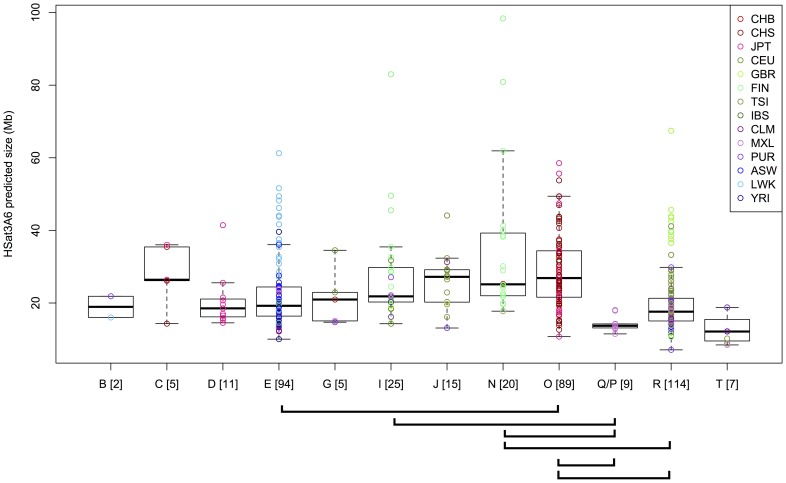
HSat3A6 (DYZ1) array size estimates in 396 individuals.Each circle represents an HSat3A6 size estimate for a single individual, and it is colored by the population designation of that individual. Individuals are grouped by Y haplogroup assignments, and boxplots illustrate the distribution of array sizes within each haplogroup. Brackets below the plot indicate pairs of haplogroups with p<0.001 in a pairwise, two-sided, two-sample Wilcoxon rank-sum test (with Holm correction for multiple testing), indicating a location shift in the distributions of array sizes between these haplogroups.